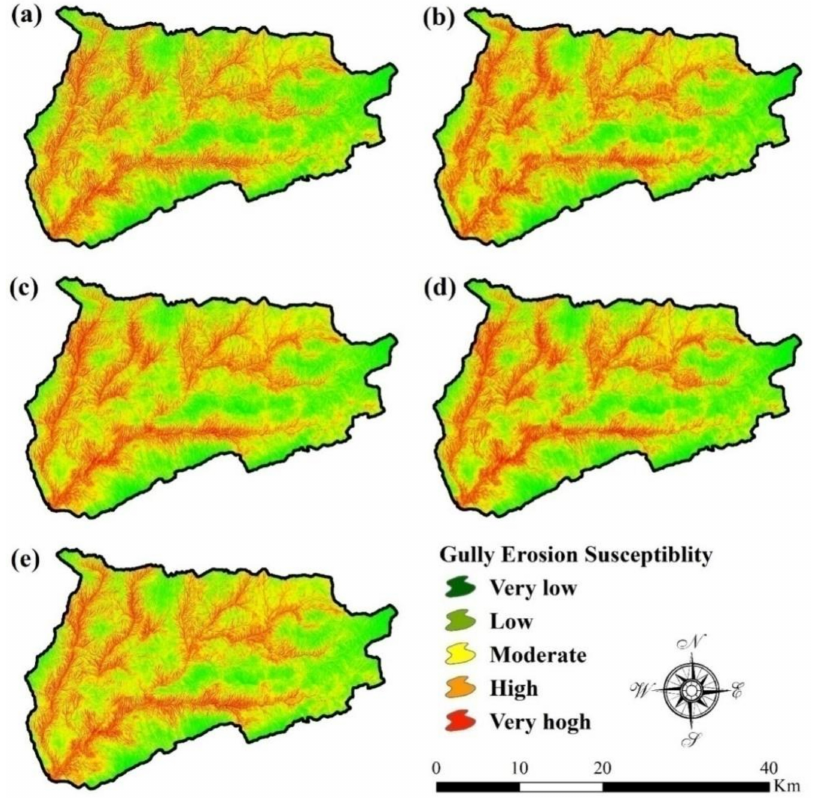
Figure 7. Gully erosion susceptibility mapping using the MaxEnt model: ( a ) 50 / 50, ( b ) 60 / 40, ( c ) 70 / 30, ( d ) 80 / 20, ( e ) 90 /